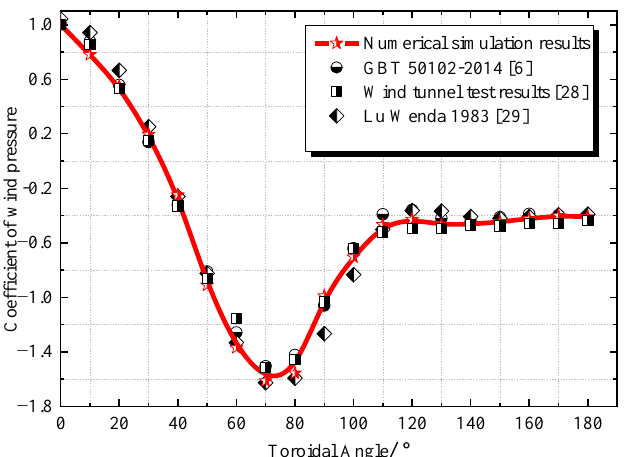
Figure 9. Simulated wind pressure distribution coefficient curves.